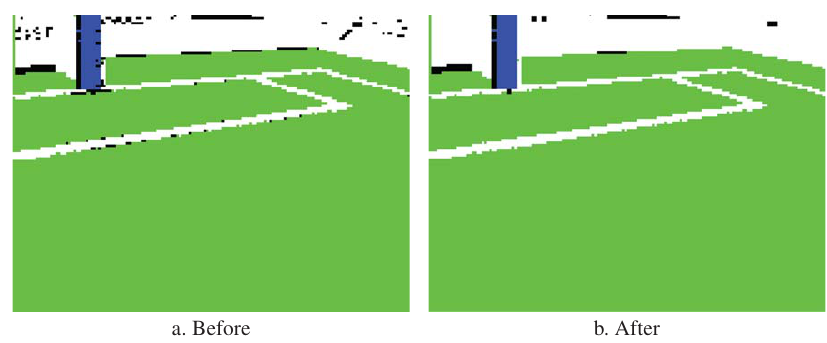
Fig. 4. The elimination of the isolating pixels. a) Before, b)